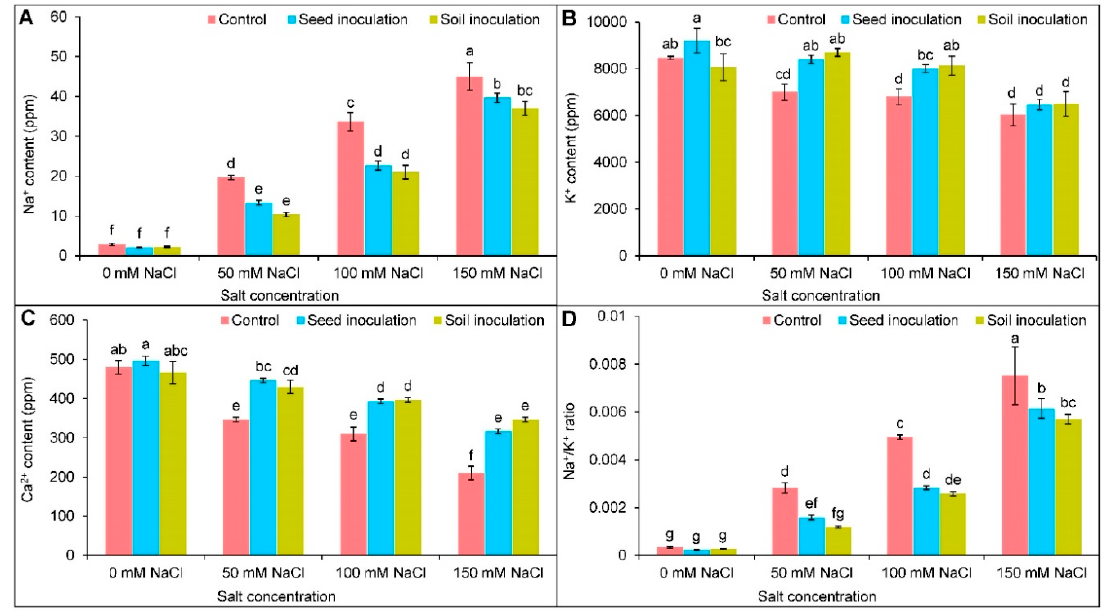
Figure 2. Effect of Bacillus subtilis in response to different concentrations of salt stress on the contents of Na + ( A ), K + ( B ), Ca 2+ ( C ), and Na + /K + ratio ( D ) of soybean ( Glycine max cv. BARI Soybean-5). Values in a column are mean ± SD. Different letters on each bar indicate significant differences among the treatment after applying a Tukey’s HSD test at p ≤ 0.05.